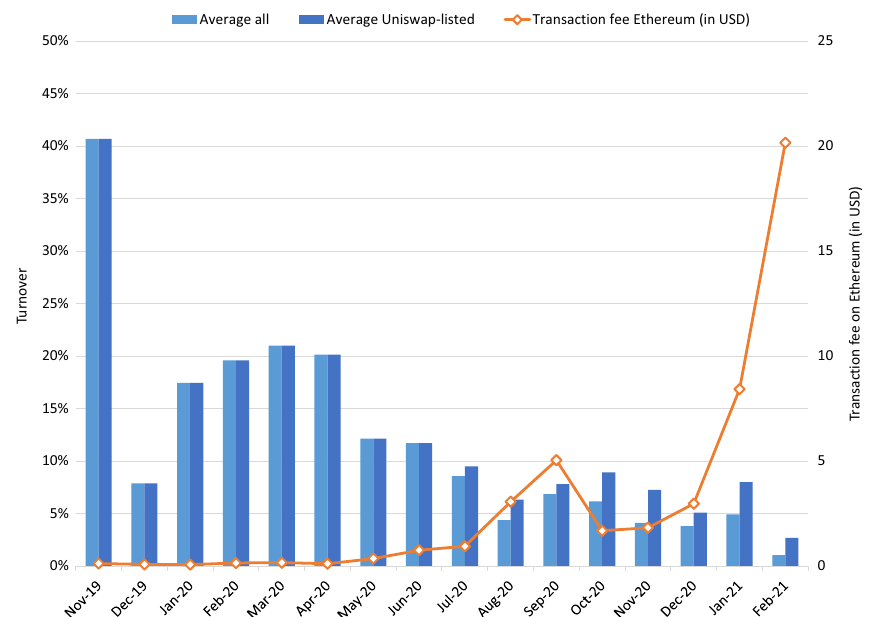
Fig. 6 Average percentage of tokens traded. Figure based on trading data from 50 properties that were tokenized in 2019 and 2020. Average daily transaction fee of Ethereum (in USD) per